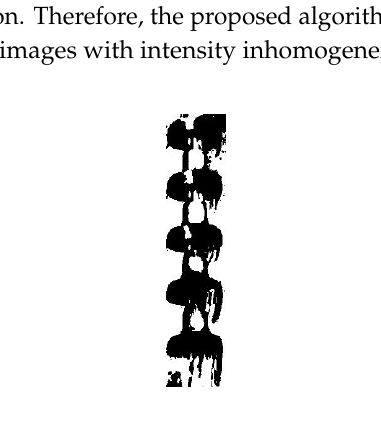
Figure 5. The binarization image after maximum entropy threshold segmentation processing.